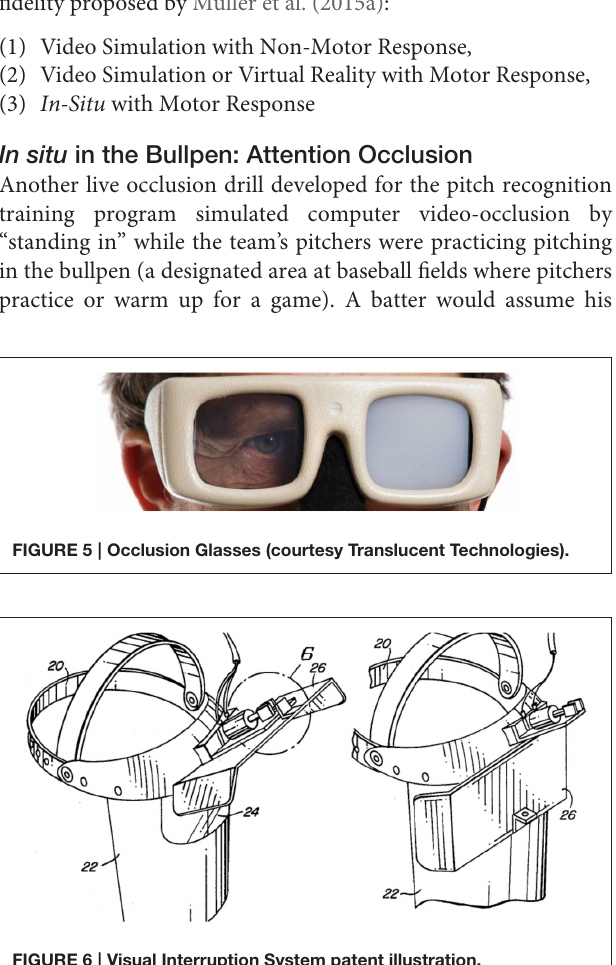
FIGURE 6 | Visual Interruption System patent